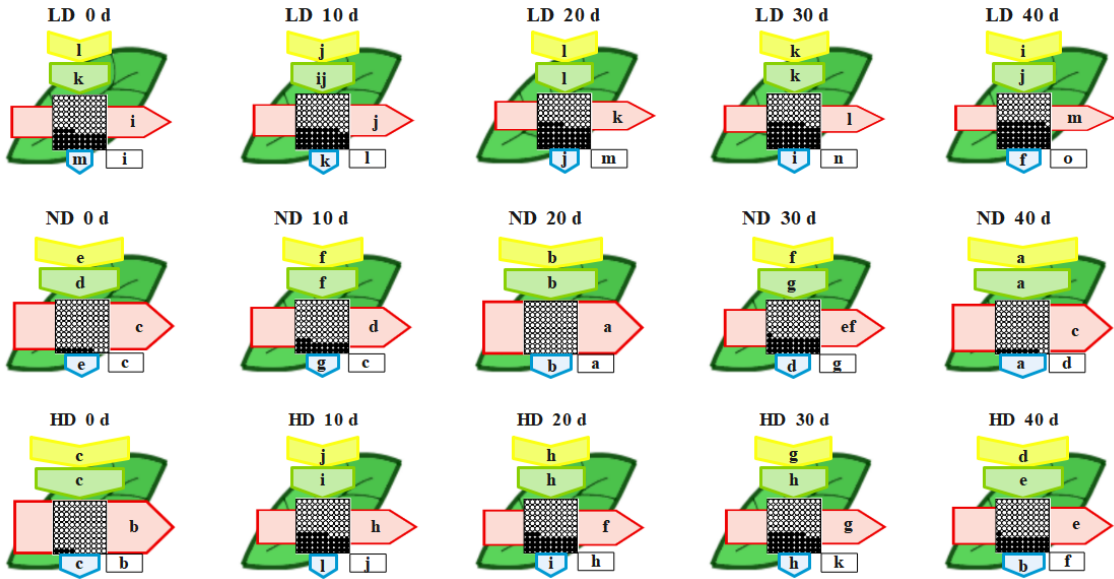
Figure 4. Leaf models showing the phenomenological energy fluxes per excited cross section (CS) of maize leaves grown under low (LD), normal (ND) and high density (HD) planting at 0, 10, 20, 30, and 40 d after anthesis. Each relative value is the mean ( n = 9), and the width of each arrow corresponds to the intensity of the flux. ABS/CS, approximate absorption flux per CS (yellow arrows); TR/CS, trapped energy flux per CS (green arrows); ET/CS, electron transport flux per CS (red arrows); DI/CS, dissipated energy flux per CS (blue arrows); RC/CS, percent of active/inactive reaction centers (circles inscribed in squares). White circles inscribed in squares represent reduced Q A reaction centers (active), black circles represent non-reducing Q A reaction centers (inactive), and 100% of active reaction centers represent the highest mean value observed during the three measured stages. Means followed by the same letter (a – m) for each parameter are not significantly different from each other using the LSD test ( p ≤ 0.05). Letters are inscribed into arrows, except for RC/CS where they are placed in a box in the lower right corner of the square with circles. LD, low density; ND, normal density; HD, high density; 0, 20, and 40 d, days after anthesis.